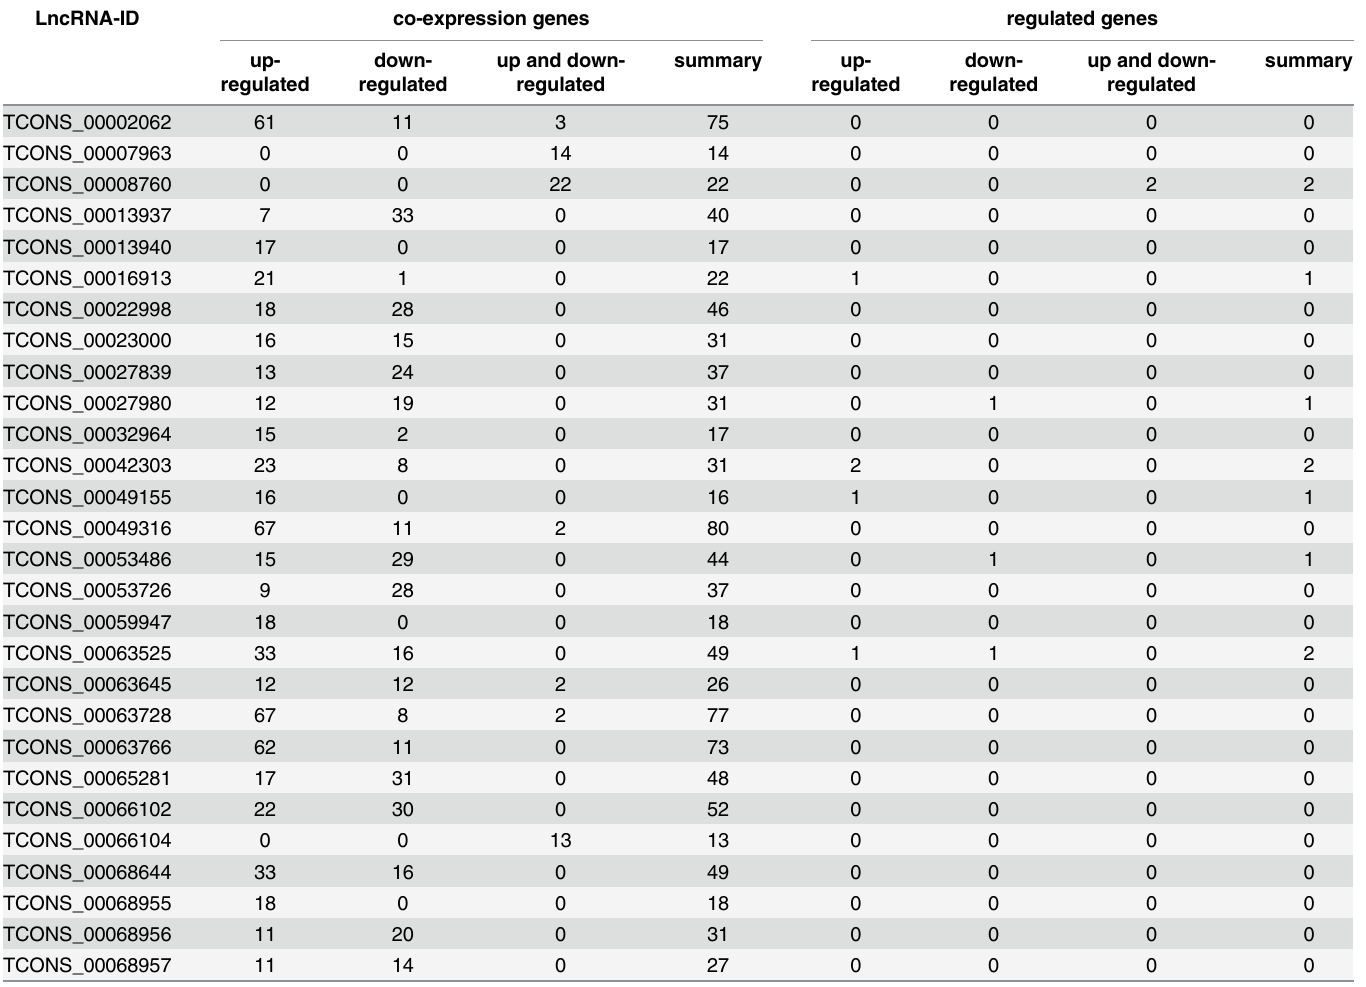
Table 2. Numbers of the regulated and the co-expression genes that related to the